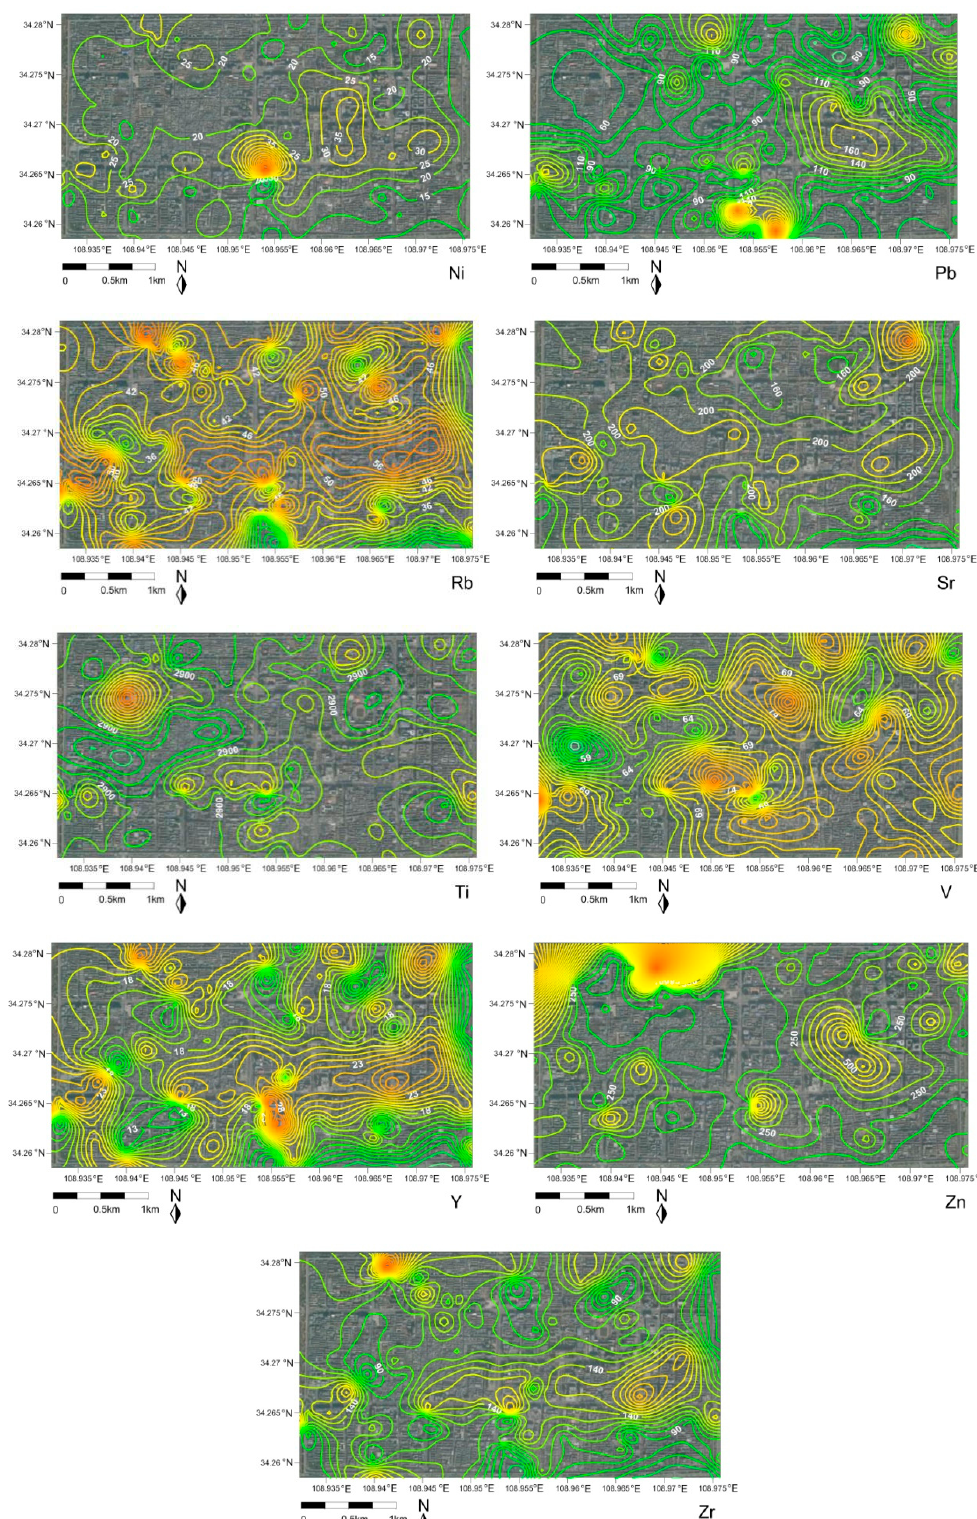
/ metalloids in street